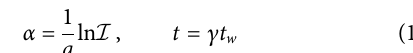
six countries/regions is shown in Figure 5 , where the blue dots indicate the data (from www.worldometer.info) while the red curve is the solution of the CeRG model. We chose to test the model against the fi rst wave data and the subsequent strolling period in Italy, France, Spain, Germany, the United Kingdom and New York state as the number of cases is large enough to provide a good statistics with a consistent testing practice. The data show that the presence of the strolling regime is a physical property of the pandemic.